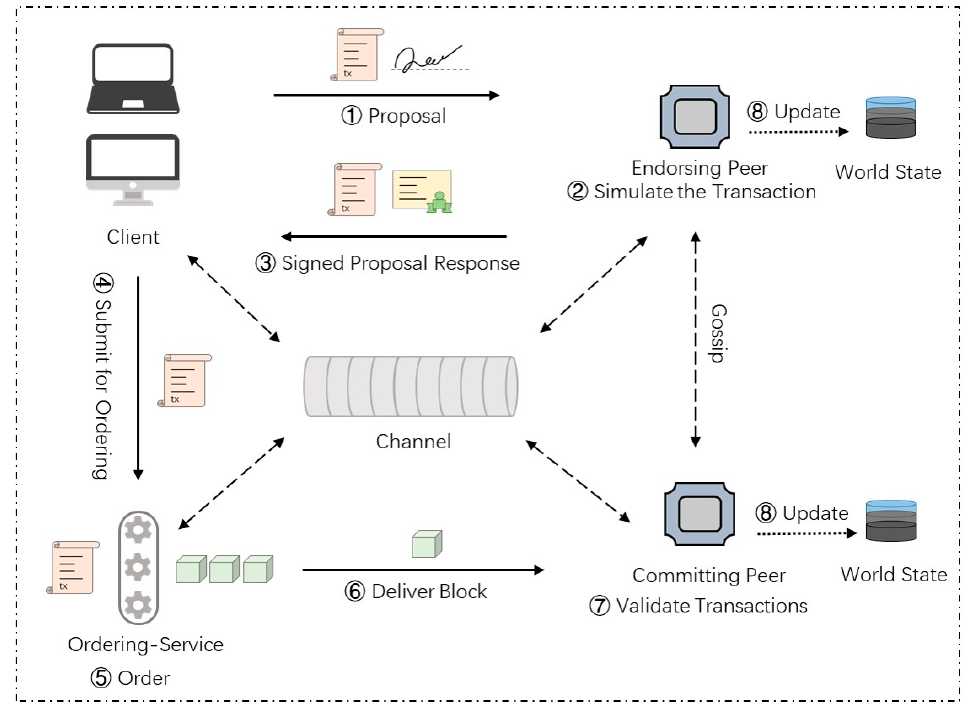
Figure 3. Workflow of a common transaction.